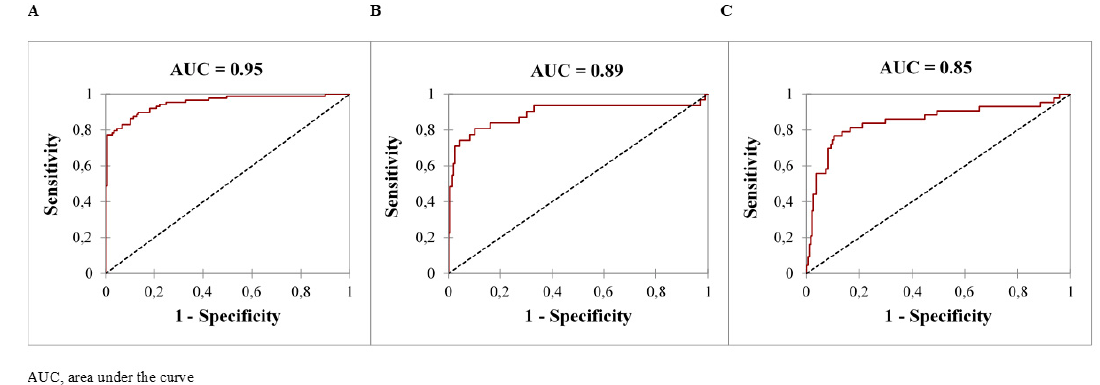
Figure3. ROCcurveofthedi ff erentpredictivemodelsofacutekidneyinjuryonset( A ),renalreplacement therapy requirement ( B ) and death ( C ) in the poisoned patients who developed